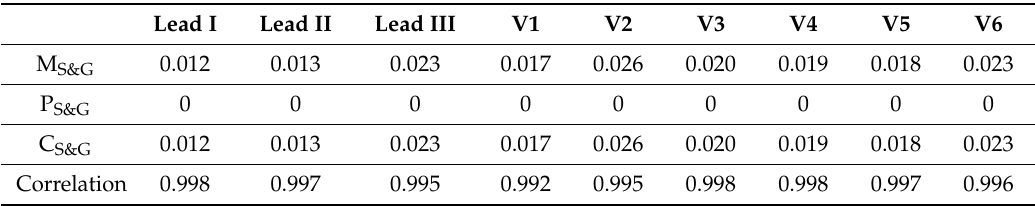
Table 4. The average Sprague and Geers’ error and correlation between recorded and reconstructed leads for 92